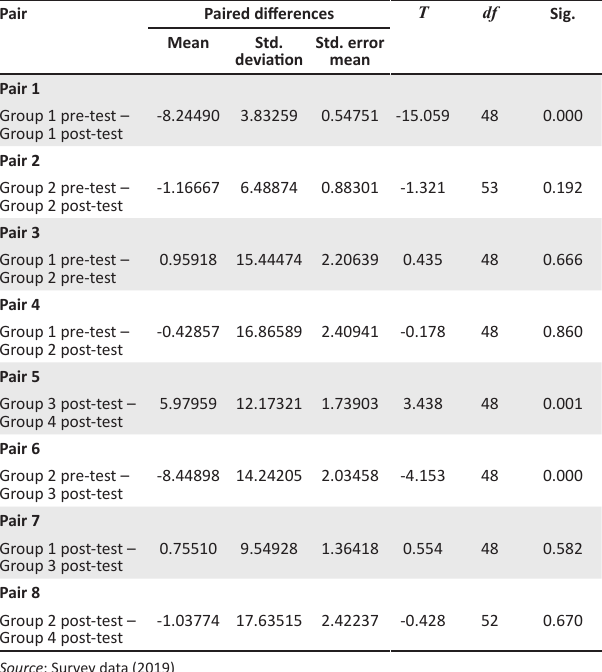
TABLE 5: Paired samples test: Solution with the four control group design. Pair Paired differences T df Sig.